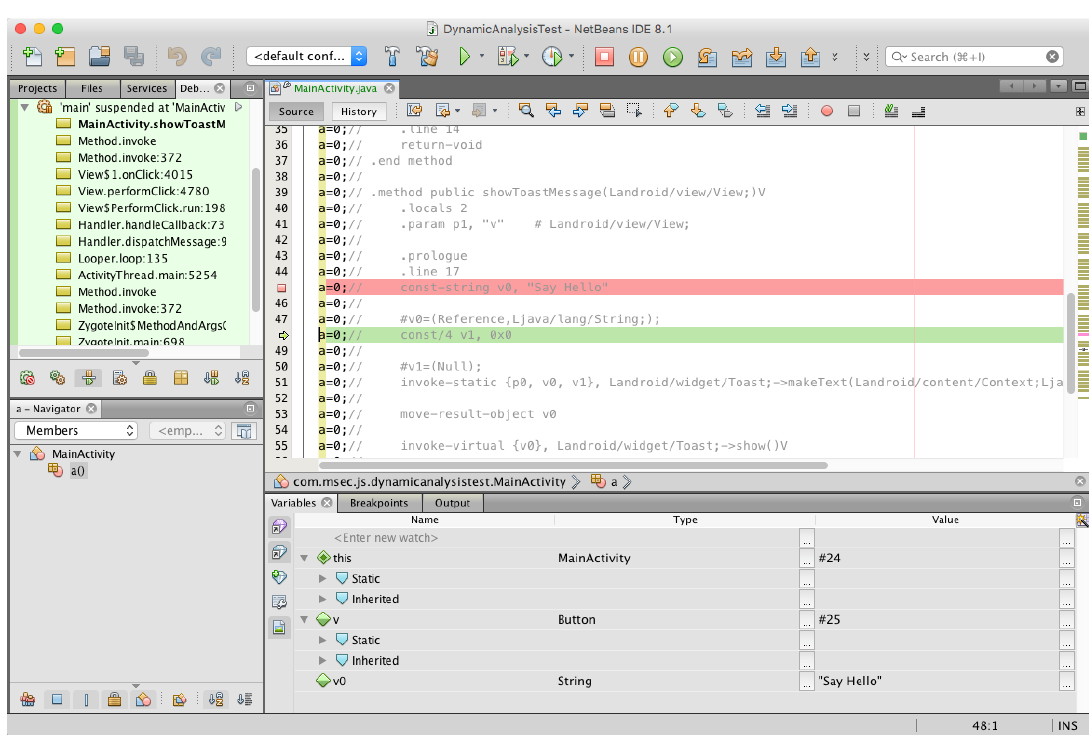
Figure 7. Dynamic analysis of an application using NetBeans